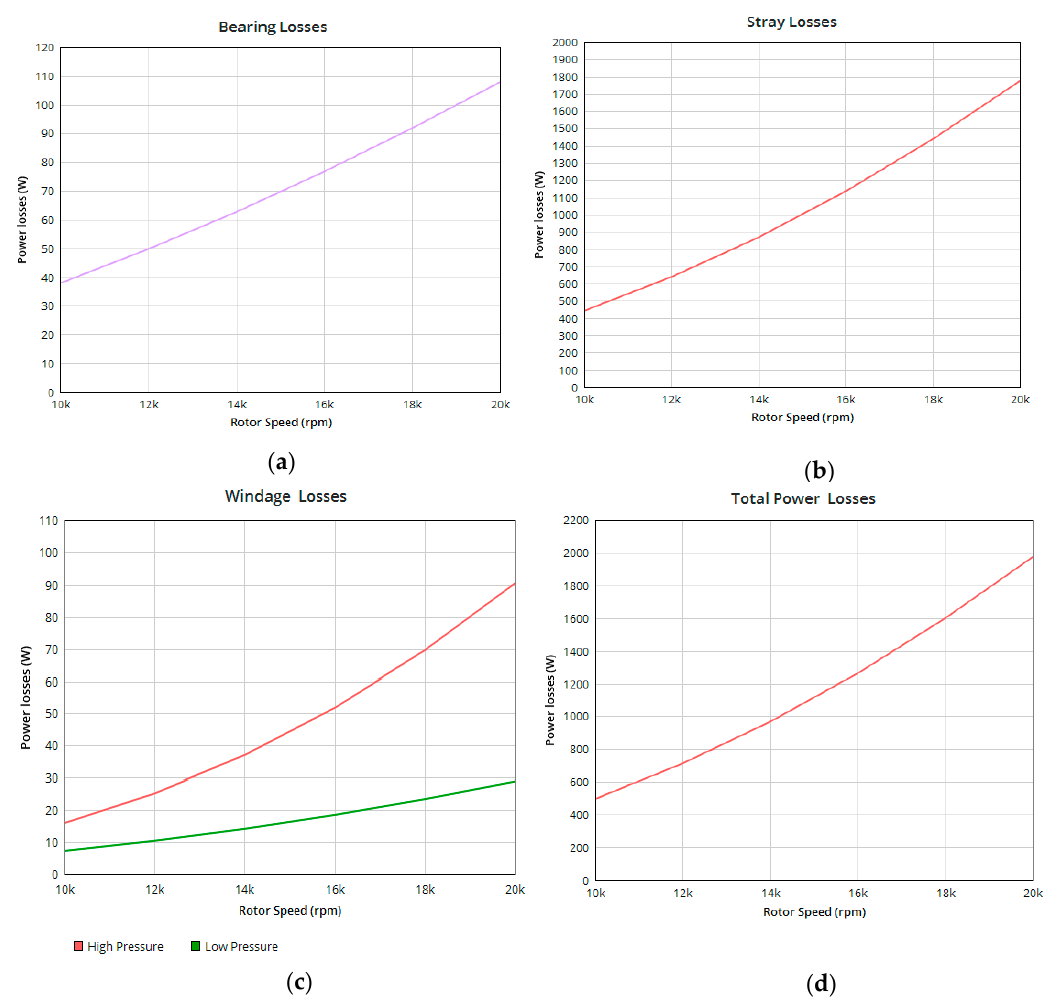
Figure 13. Different mechanical losses of SCIM-FESS: ( a ) Bearing losses due to load and speed torque; ( b ) Stray losses due to magnetic flux leakages; ( c ) Windage losses at low and high pressures;( d ) Total mechanical losses.